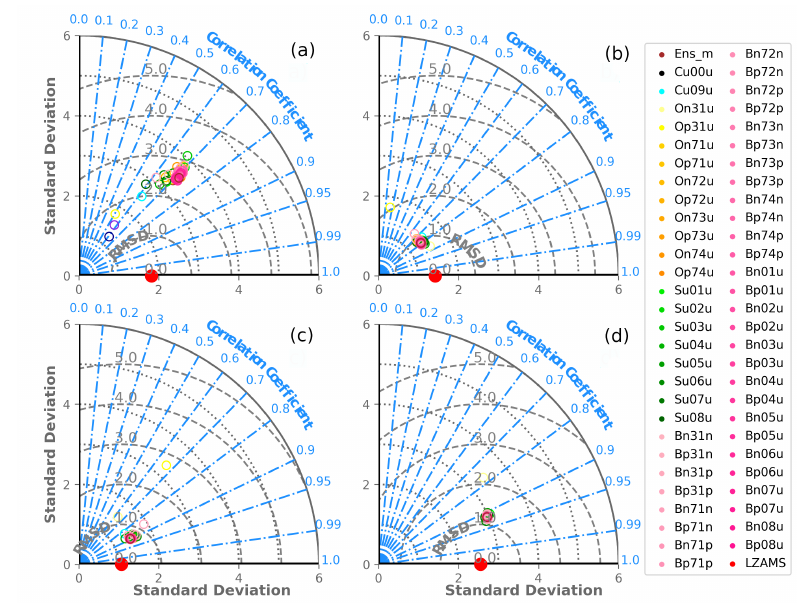
Figure 11. Taylor diagrams for ( a ) precipitation, ( b ) water vapor mixing ratio, ( c ) temperature and ( d ) pressure computed from hourly data from the Lopez Zamora Meteorological Station used as a reference. WRF data is taken from the domain point closest to the station location. Valid for the simulation period starting at 00Z on 27 February 2017. Dark blue and violet circles in ( a ) correspond to ERA5-Land, and IMERG datasets evaluated at the point closest to the station location,